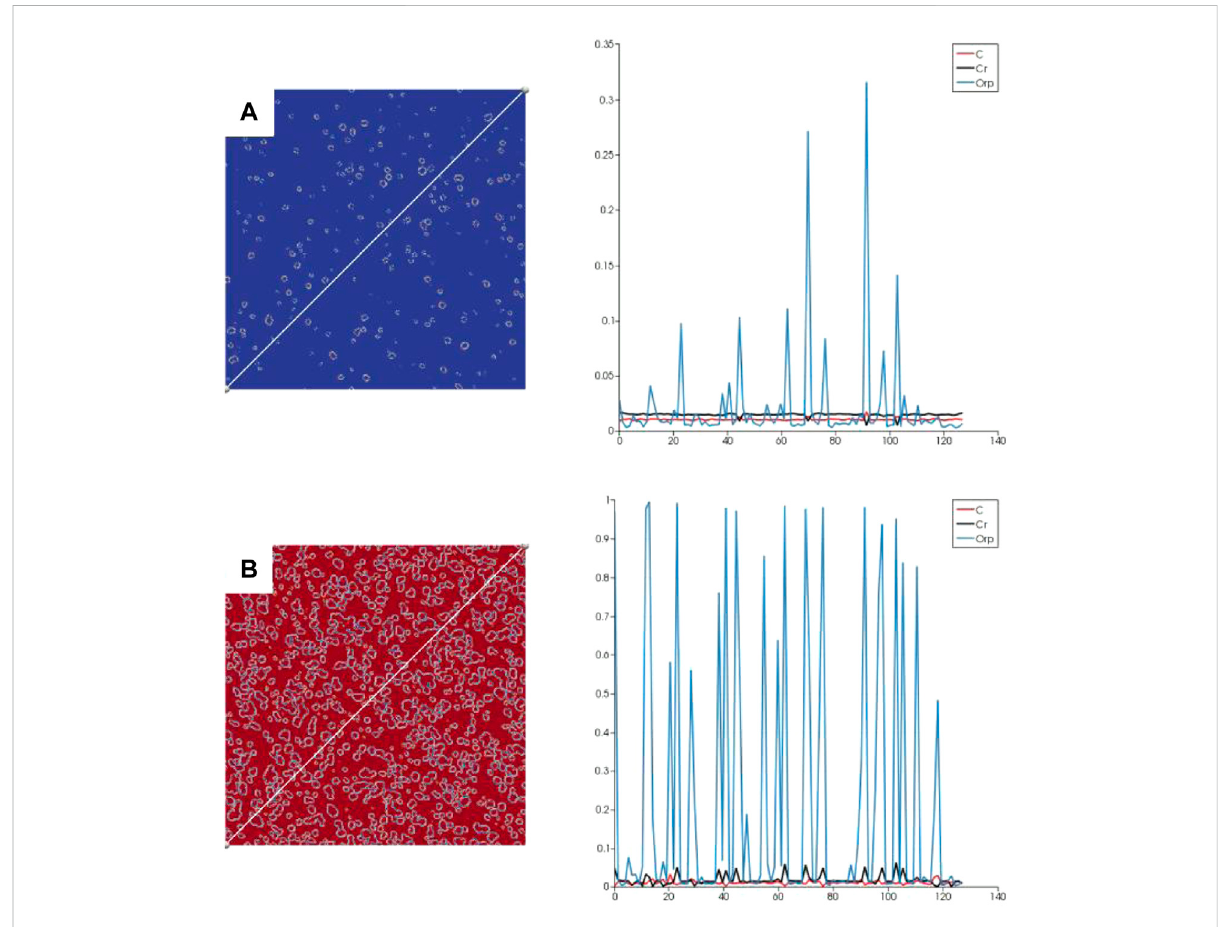
FIGURE 10 Concentration versus time curve along the concentration fi eld diagonal. (A) Carbon concentration fi eld. (B) Cr concentration fi